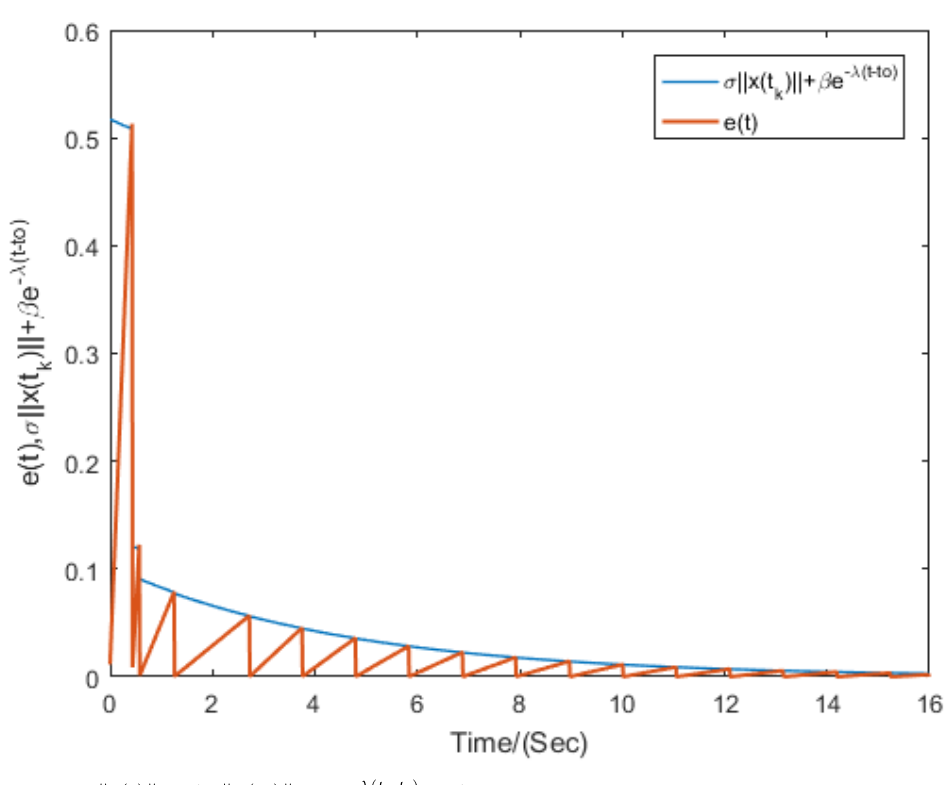
Figure 4. (cid:107) e ( t ) (cid:107) and σ (cid:107) x ( t k ) (cid:107) + β e − λ ( t − t 0 ) with τ = 0.1